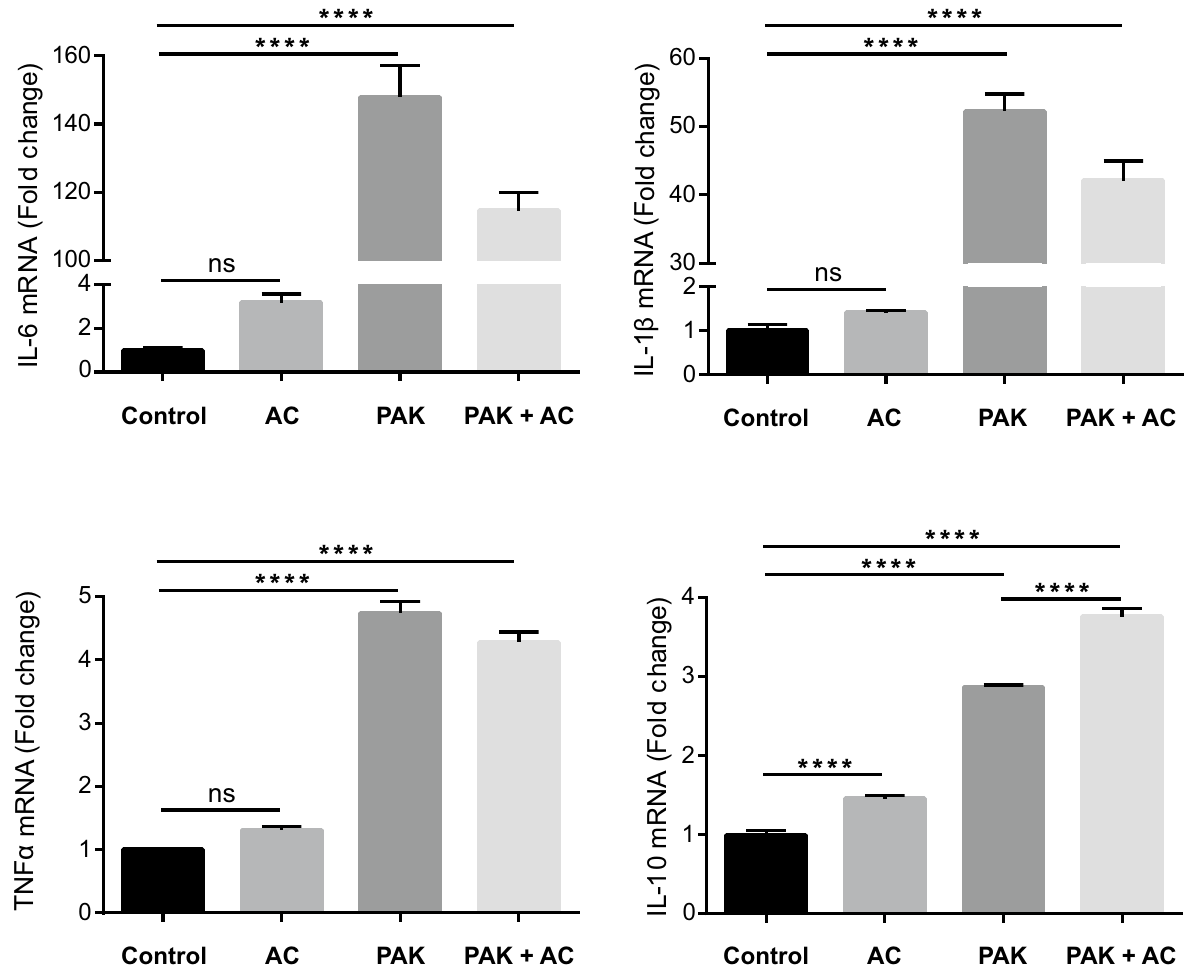
Figure 4. BMDM cytokine gene expression profile elicited by the different stimuli. Cytokine gene expression was determined in BMDM after different pre-stimuli treatment and expressed as a fold change with respect to Control. BMDM were incubated for 50 min with different pre-stimuli: AC (apoptotic cells), PAK (bacteria), PAK + AC (PAK with AC concurrently) and Control (non-stimulus). Six hours after the initiation of the experiment, RNA was extracted. Four mRNA cytokines were tested by RT-qPCR: Il-6 , Il-1β , Tnfα and Il-10 . Data is presented as mean Fold Change ± SD. One of three independent experiments normalized to Ywhaz mRNA levels is shown. ****p < 0.0001 vs. Control by one-way ANOVA, followed by Tukey’s multiple comparison